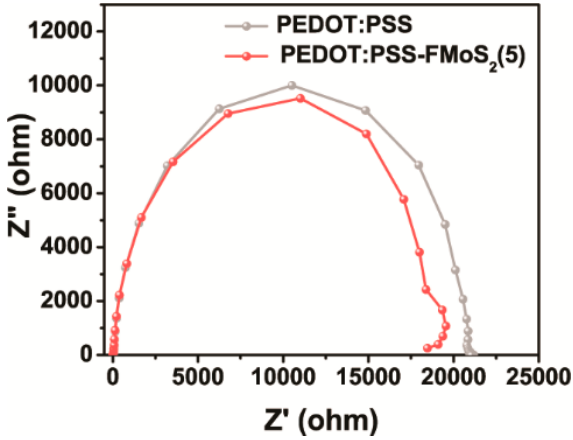
Figure 6. Electrical impedance spectra of organic solar cells based on poly(3,4-ethylenedioxythiophene):poly(styrenesulfonate) (PEDOT:PSS) and PEDOT:PSS / oleylamine-functionalized MoS 2 (5 µ L) (PEDOT:PSS / FMoS 2 (5)) as hole-transportation layer.